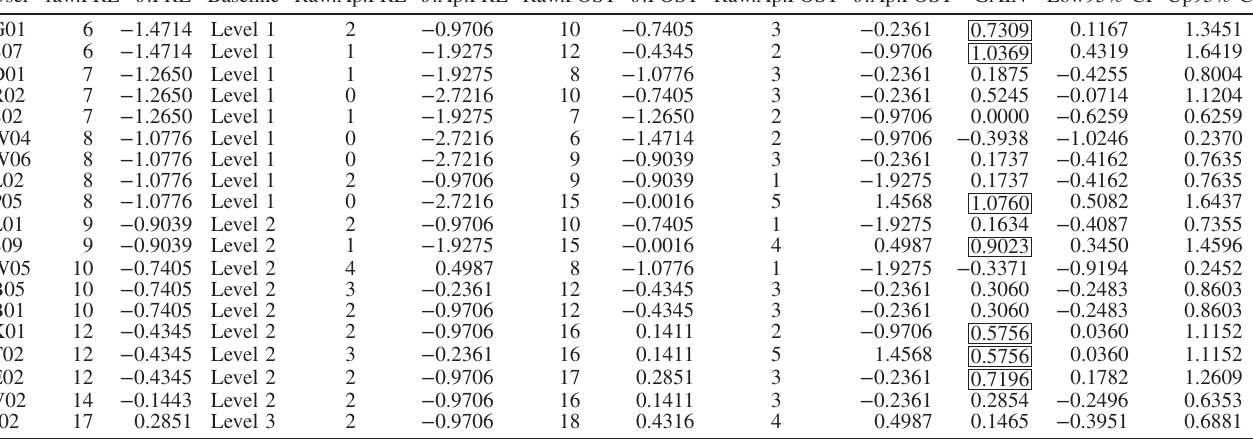
TABLE X. Baseline category and ability gain for the students repeating the PSCI testing at Oklahoma State University. ˆ θ : PRE (POST) ¼ person ’ s measure on the PSCI reference Raw.PRE (POST) ¼ raw score for 30-items at pre- and at postinstruction; scale; Baseline ¼ ability category before instruction; raw.Ap.PRE (POST) ¼ raw score for the 6-item application subset; ˆ θ : Ap : PRE (POST) ¼ person ’ s measure on the application subscale; GAIN ¼ ability gain, difference from PRE to POST; low(up) 95% CI ¼ lower and upper boundaries of the 95% confidence interval for the ability gain; boxed values ¼ significant ability gain.